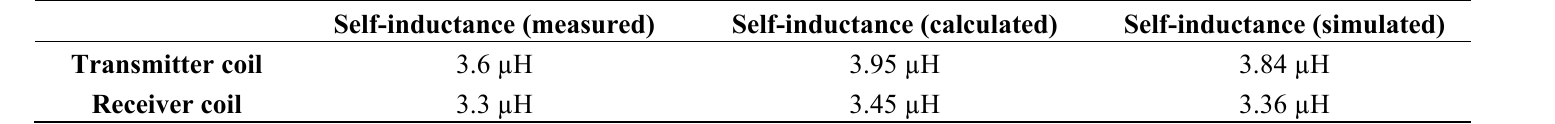
Table 4. Self-inductance of transmitter and receiver